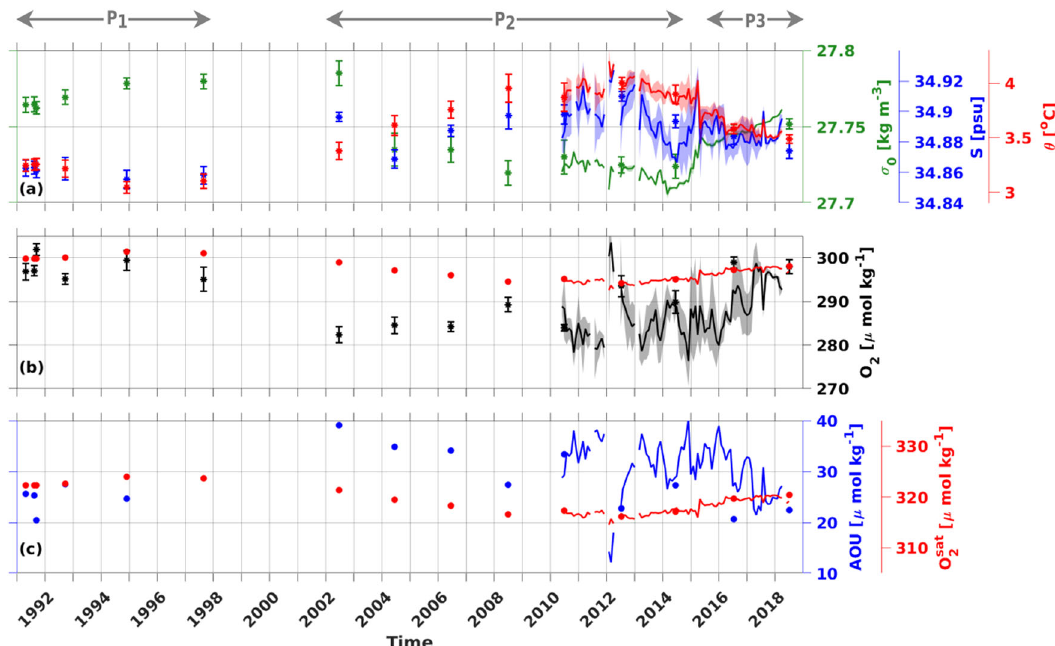
Fig. 2 Temporal variability of the Labrador Sea Water properties in the Irminger Sea. a Salinity (blue curve; psu), potential temperature θ (red curve; ∘ C), and potential density σ 0 (green curve; kg m − 3 ). b Oxygen concentration O 2 (black curve; μ mol kg − 1 ) and the oxygen at 93% of saturation (red curve and dots). c Apparent Oxygen Utilization AOU (blue curve; μ mol kg − 1 ) and oxygen at saturation O sat (red curve; μ mol kg − 1 ). Plain curves represent Argo data, 2 and dots represent the hydrographic sections. The uncertainty for the Argo data is computed as the standard deviation around the spatial average (gray shading), and for the hydrographic section it is computed as the standard deviation over the layer depth (error bars). The three periods (P 1 , P 2 , and P 3 ) discussed throughout the manuscript are indicated with arrows on top of the fi gure.